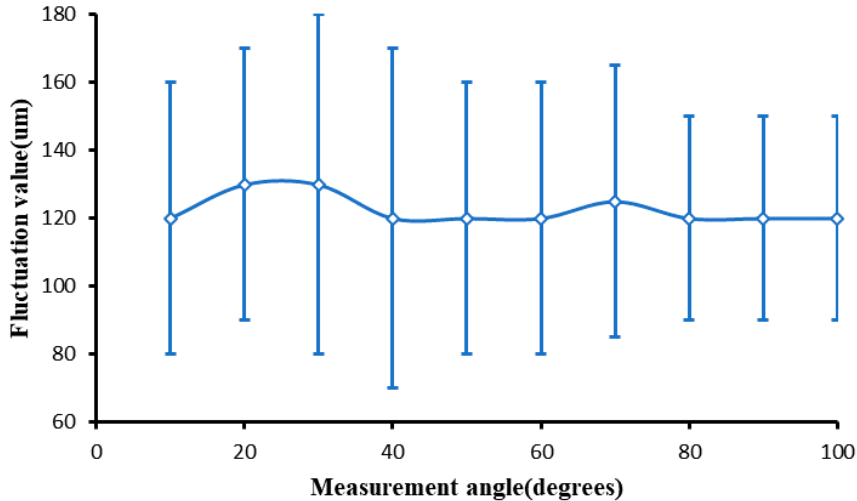
Figure 9. Variation of ribbon fluctuation along the surface of the polishing wheel.